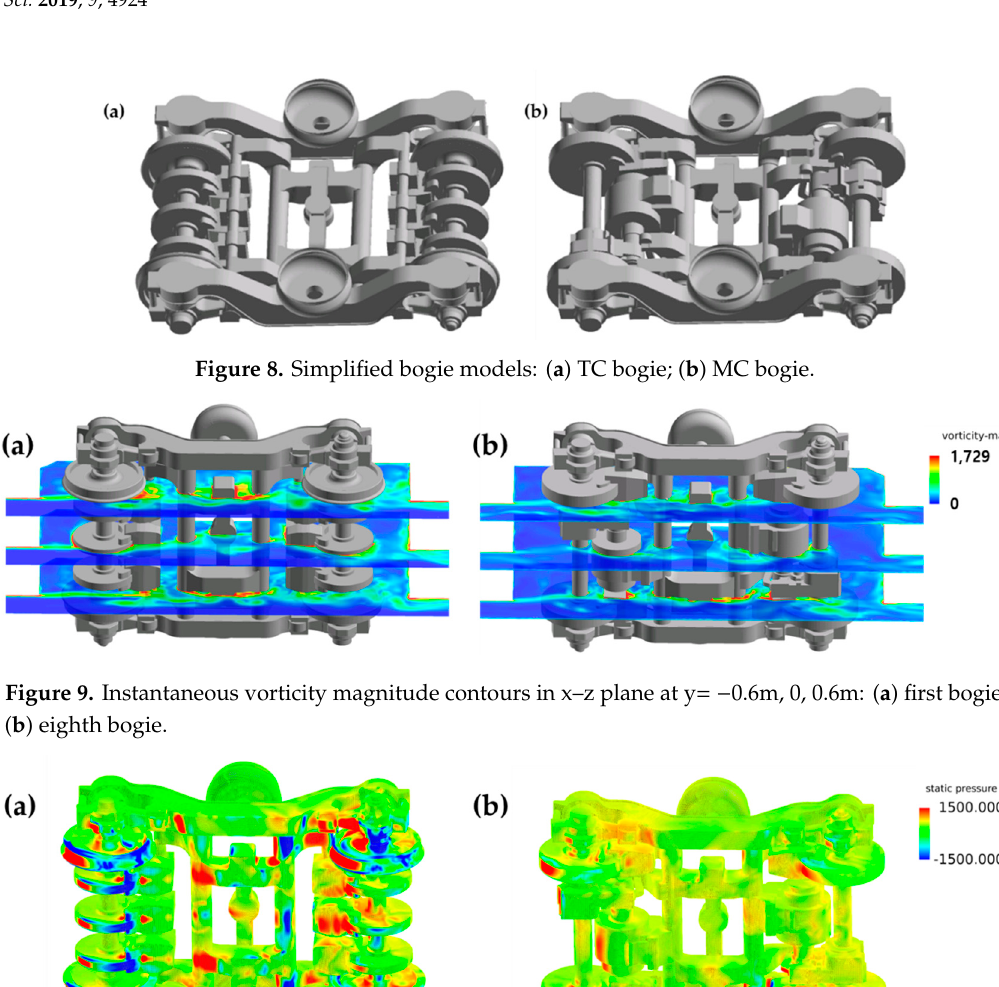
Figure 12. Instantaneous vorticity magnitude contours on the x-z plane at y = 0 m: ( a ) first pantograph; ( b ) second pantograph. 4.4. Intercoach Space Intercoach space is one of the main noise sources of a high-speed train. Intercoach space can be categorized as an open cavity that has a large or small streamwise length-to-depth ratio [2]. In an open cavity which is also known to be aerodynamic noise source, the shear layer is separated from the leading edge of cavity and spans the entire length of cavity or roll-up to quasi-periodic vortices. The shear layer or vortices hit the solid rear wall of the cavity and generate aerodynamic noise by converting the vortical energy to acoustic energy. The acoustic waves propagating upstream hit the leading edge of the cavity and enhance the development of the shear layer. This feedback phenomenon sometimes strengthens the aerodynamic noise by the resonance of its feedback frequency with the cavity acoustic modes. Figure 13 shows the iso-contours of instantaneous vorticity magnitude in intercoach regions. Typical shear-lay vortices in the wide-open cavity were identified in the upper part cavity, while the closed shear layers in the narrow open cavity were formed in the side part cavity of the intercoach space. Compared to the typical open cavity, however, the flow structure in the upper part of first intercoach space showed a more complex pattern. A strong shear layer was formed from the wind-shield and induced fluid flow from the inside cavity to the outside in the upper part of the cavity of the first intercoach region. Figure 14 shows the streamlines of fluid passing around the intercoach space. Heavy spiral flow was generated from the bogie side and rose to the roof side in the first intercoach space. On the other hand, spiral flows originated from the upper intercoach spaces in the second and third intercoaches. These complex vortices caused aerodynamic noise in the intercoaches, which was observed in Figure 7.